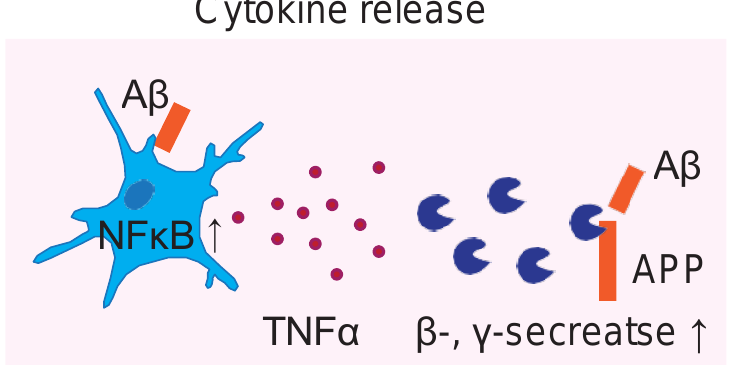
Figure 1. Various responses of microglia to amyloid β. Cytokine release: Aβ directly stimulates TNF-α production in microglia by activating the transcription factor NF-κB. TNF-α increases the expression of β- and γ-secretase which generate Aβ from APP.